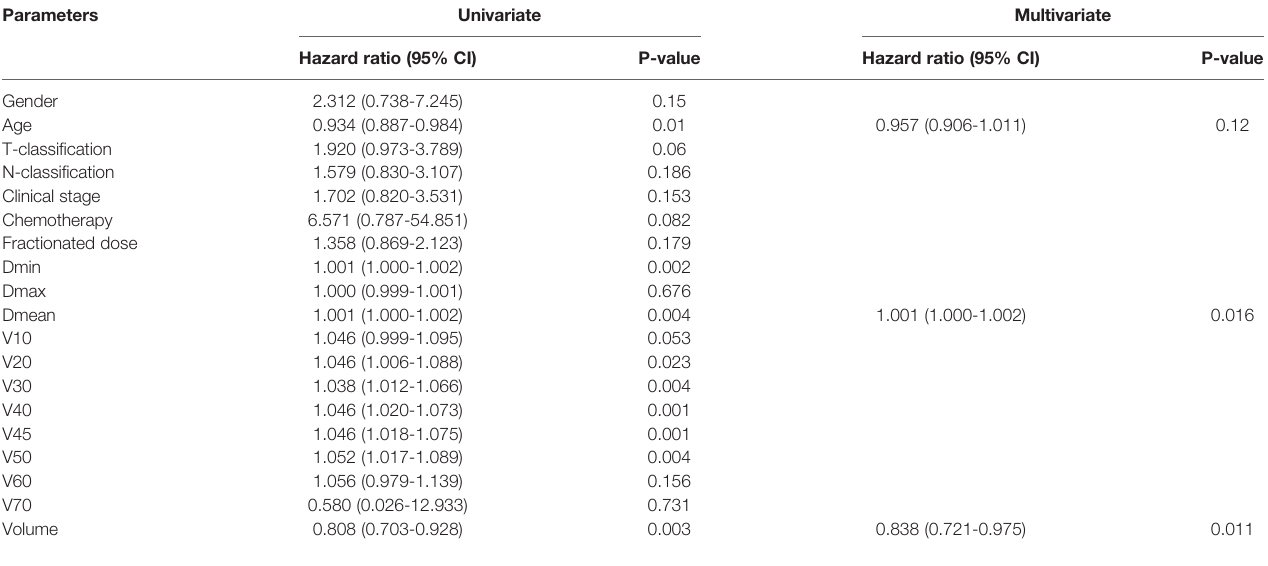
TABLE 2 | Univariate analysis and multivariate analysis of radiation induced hypothyroidism. Parameters Univariate Multivariate